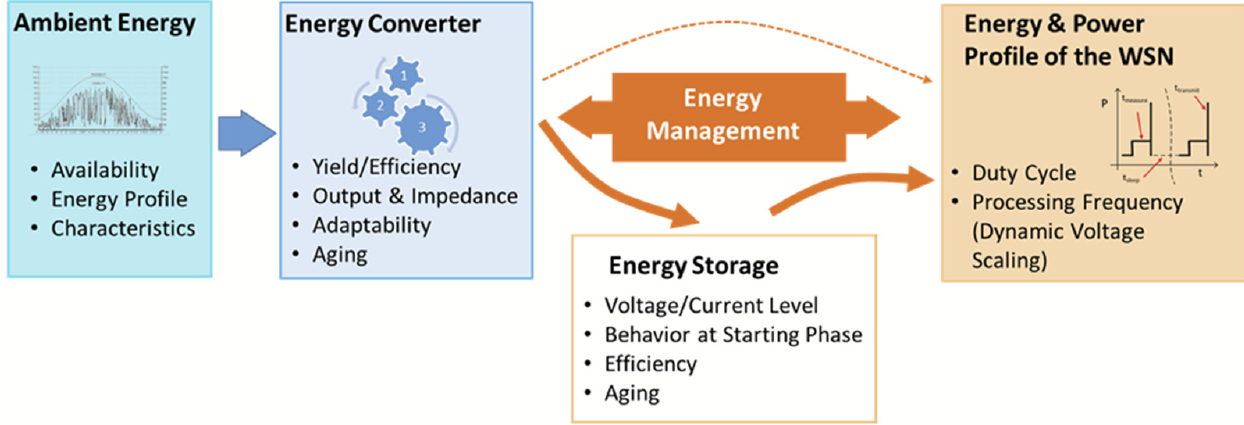
Figure 1. Challenges for the supply of WSNs with energy harvesting.